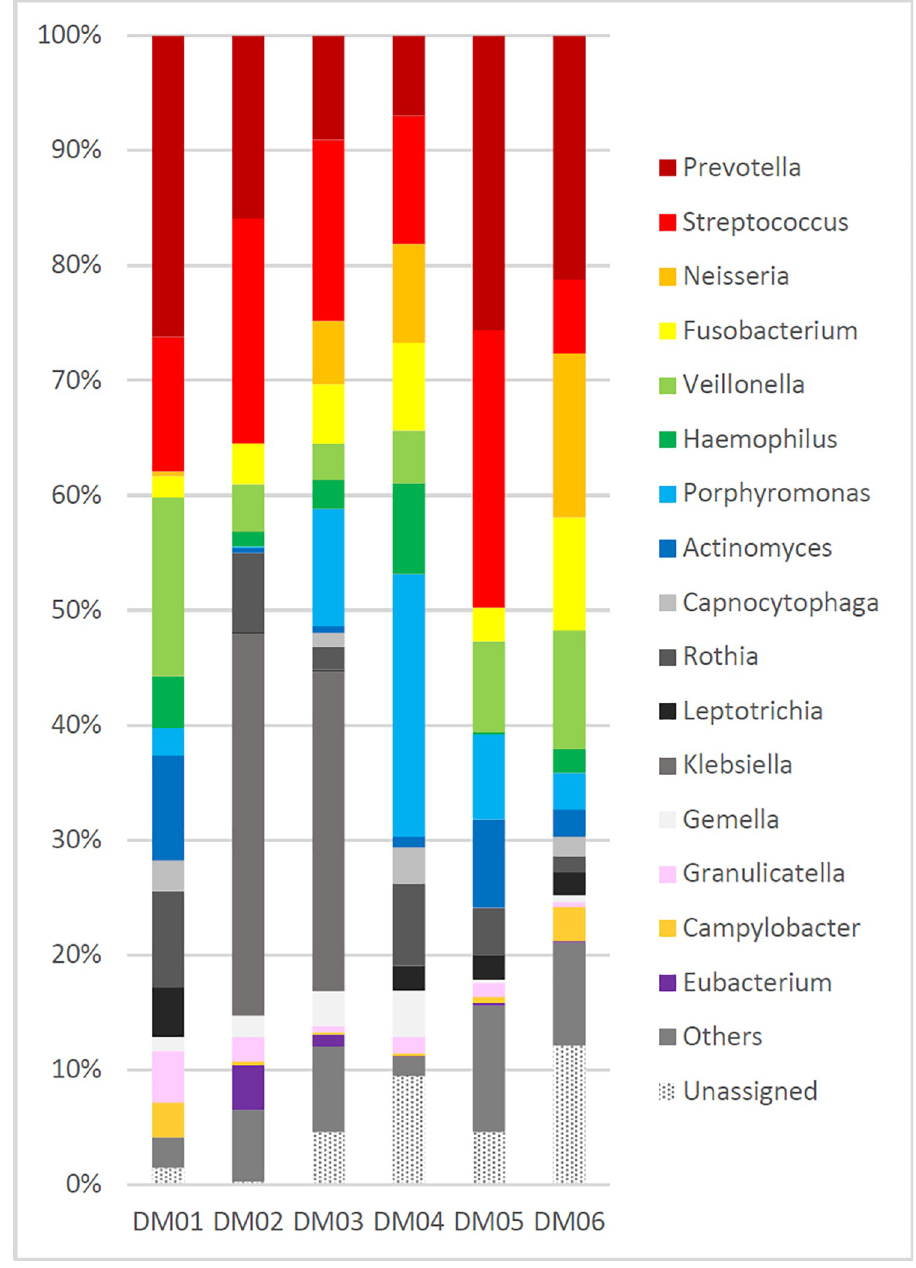
Fig 3. Relative abundance of microbial community constituents in endotracheal tube washings from six diabetic patients. Taxa that did not show more than 3% abundance in at least one specimen were designated as “others”.